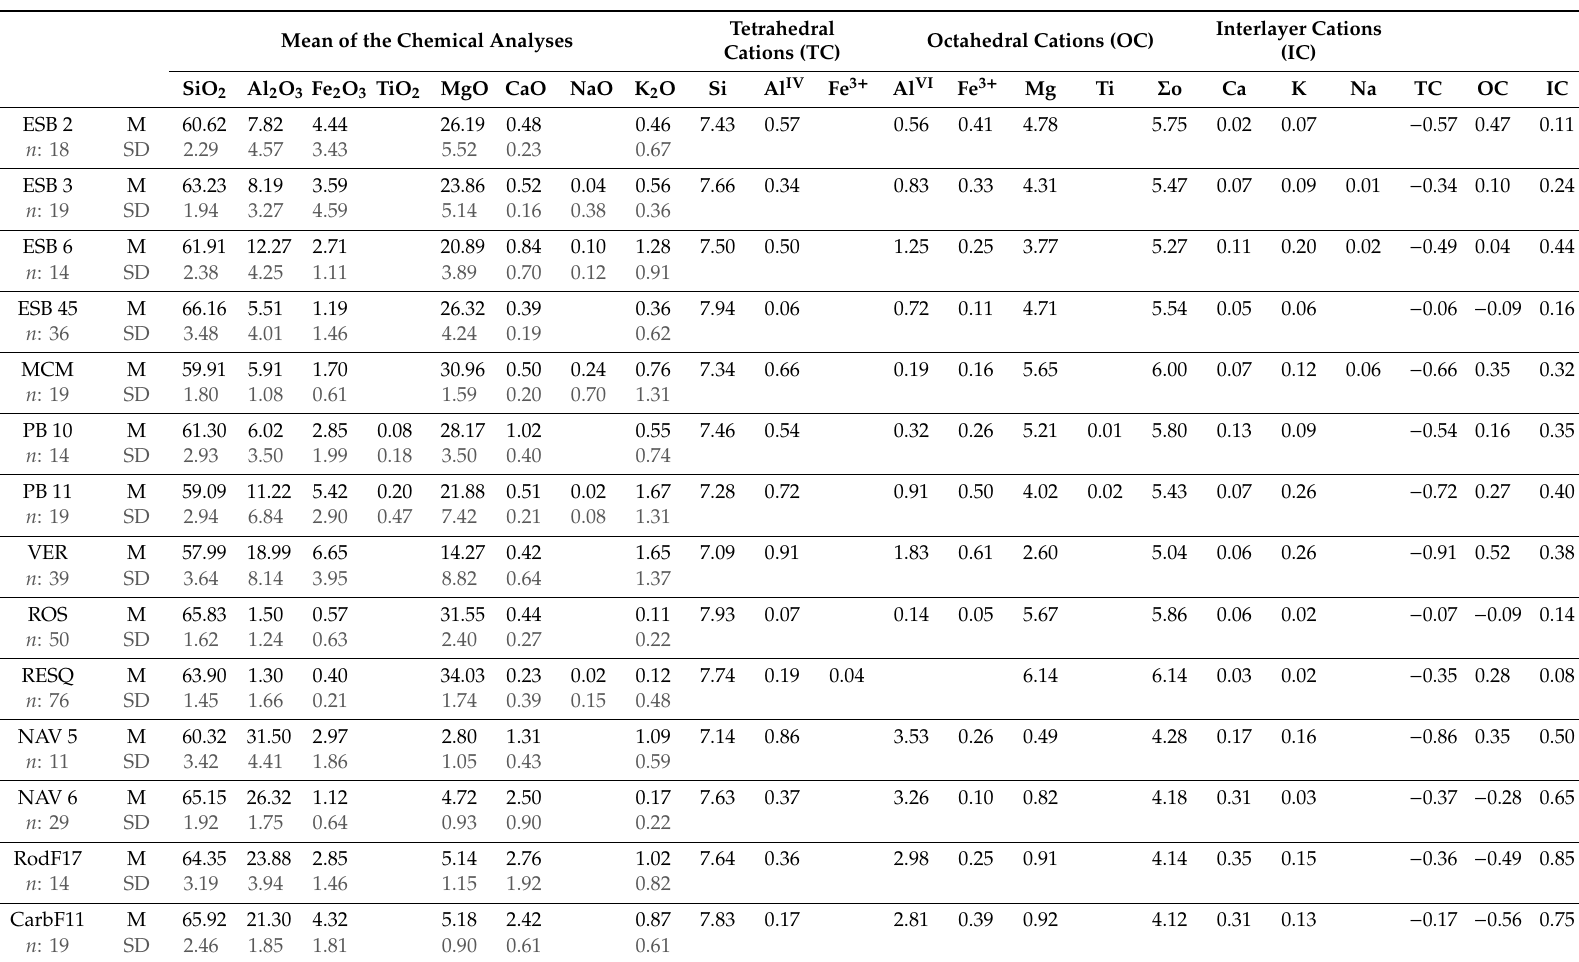
Table 3. Chemical composition of individual particles obtained by point analyses in analytical electron microscopy (AEM) and structural formulae of the studied samples obtained from the means of the chemical analyses acquired. M: mean, SD: standard deviation, n : number of